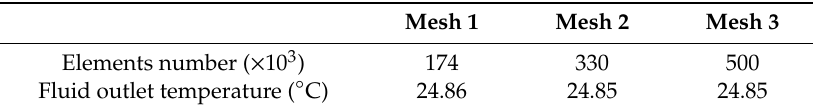
Table 2. Grid-independency test of smooth U-tube GHE .